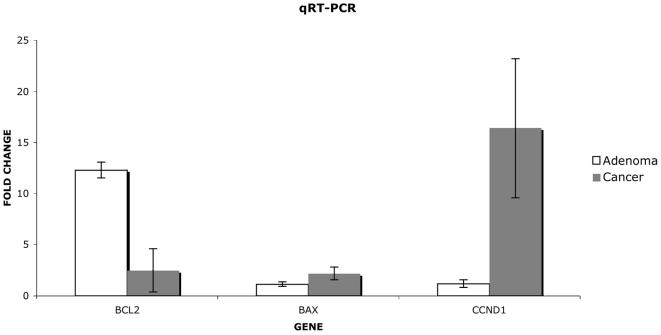
qRT-PCR validation of microarray results.The expression patterns of BCL2, BAX and CCND1 in 4 tissue samples were determined using quantitative RT-PCR. In all cases, the qRT-PCR results of the analyses confirmed the differences detected in the microarray studies.